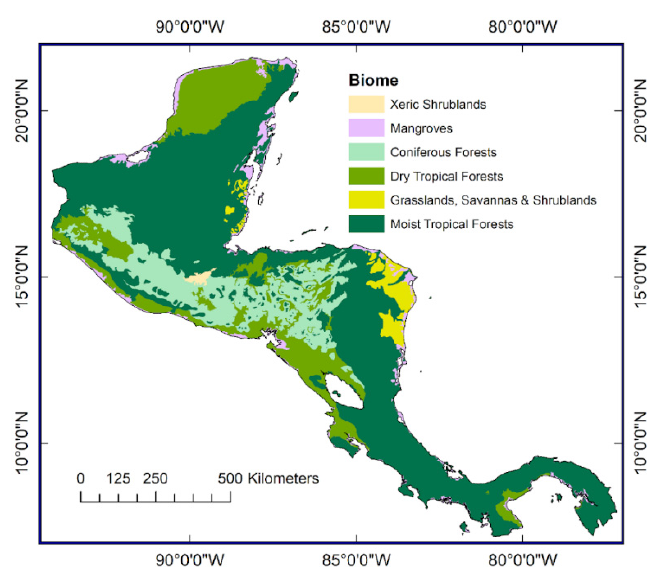
Figure 1. Biomes of the Central American Isthmus. Based on Dinerstein et al. [8]. Moist tropical forests are dominated by semi-evergreen and evergreen deciduous tree genera, such as Alnus , Cassipourea , and Hevea [9], and contain the highest tree species diversity of all the terrestrial biomes [3]. This biome can be further subdivided by ecore- gions according to their altitudinal distribution, grouping them into lowland (<1000 m) and upland (>1000 m) areas [8]. The lowland moist broadleaf forests are distributed in continuous strips (e.g., the Petén-Veracruz moist forests and Central American Atlantic moist forests), whereas the montane moist tropical forests are naturally fragmented by elevation (e.g., the Central American montane forests). The main drivers of land use change in this biome are agricultural and infrastructure expansion [10 , 11].